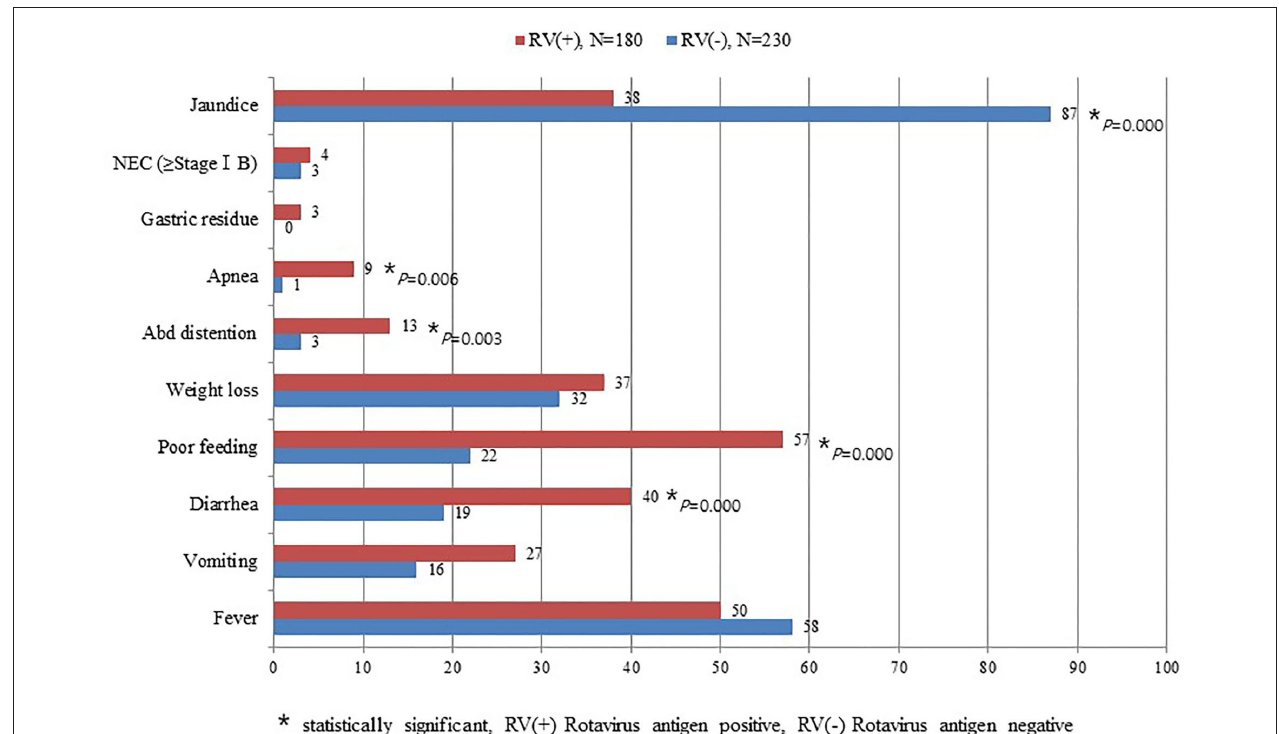
FIGURE 2 | Comparison of clinical symptoms between patients with and without rotavirus infection.